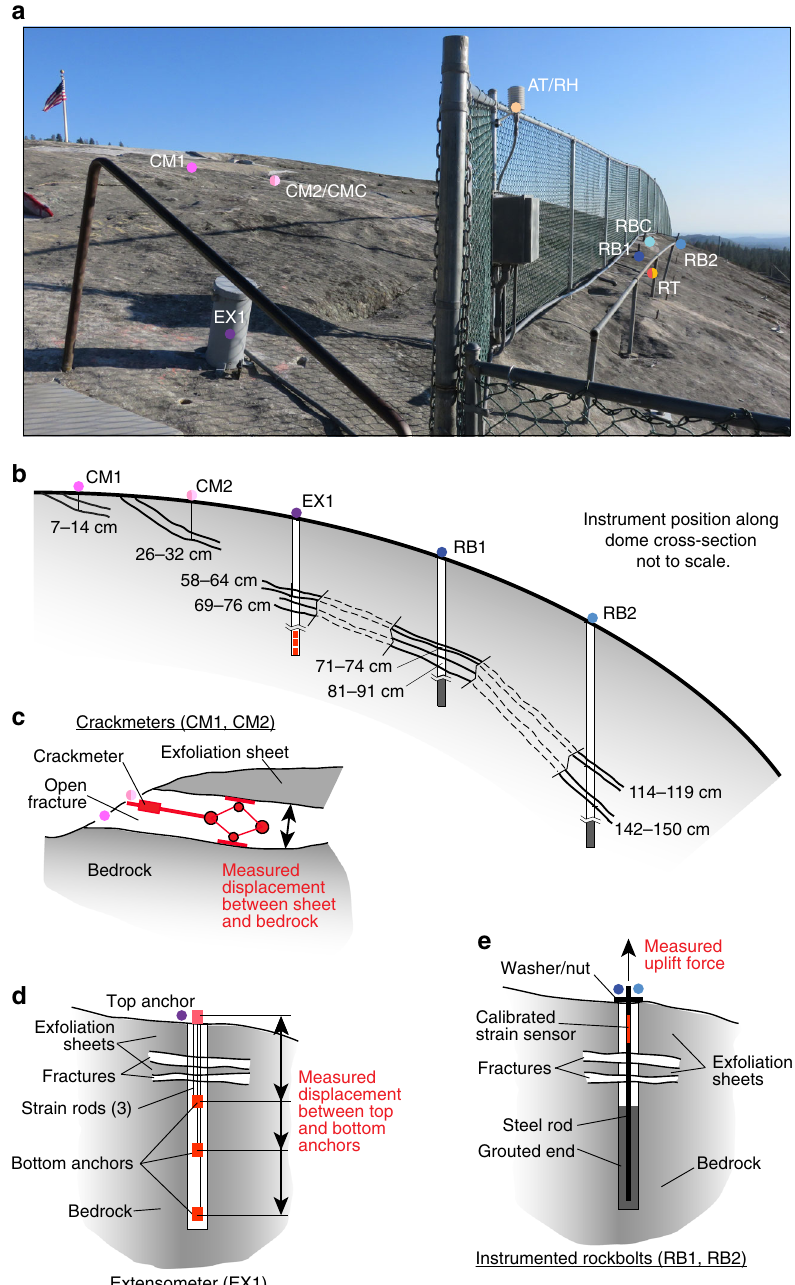
Fig. 3 Exfoliation dome instrumentation layout and schematic diagrams of deformation and force monitoring equipment. a A suite of instrumentation is deployed across the most active area of exfoliation. Symbols, instrumentation labels, and scale are as described in Fig. 1. b Instrument installations intersect several exfoliation sheet fractures at depth depending on their position across the dome. Fractures are open across the annotated depths and are to scale. Note that instrument positions along the cross-section are not to scale (i.e., the instrumentation is not in-plane as shown; see Fig. 1 and a for true spatial layout). Crackmeters, extensometers and rockbolts measure longitudinal strain, which is converted to deformations and force through linear elastic constants speci fi c to the geometry and design of each instrument. c Crackmeters measure exfoliation sheet fracture aperture width by installation directly within fractures. d Extensometers measure exfoliation sheet fracture aperture width by installation across fractures through anchoring on either side of a fracture. In our extensometer installation, three instruments provide redundant measurements across the fractures. e Rockbolts measure exfoliation sheet uplift force generated along a steel rod that is grouted and fi xed in bedrock at one end, and tightened to the surface of the deforming exfoliation sheet at the other end. Forces are converted to stresses through approximations of exfoliation sheet attachment geometry. See Methods for additional details